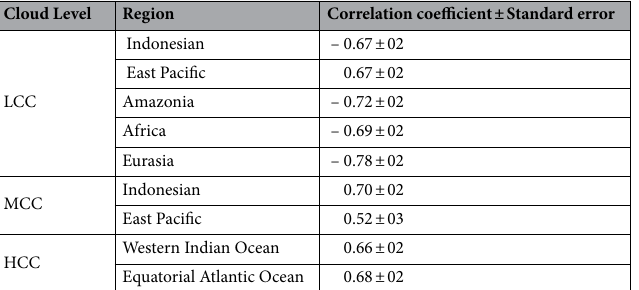
′ anomaly series for selected